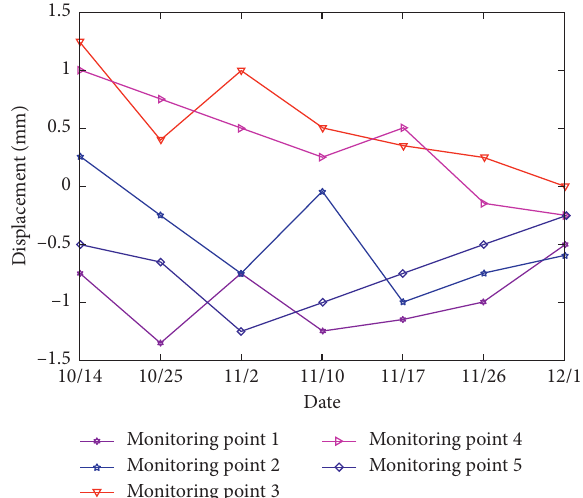
Figure 7: Surface displacement trend of monitoring points 1–5.